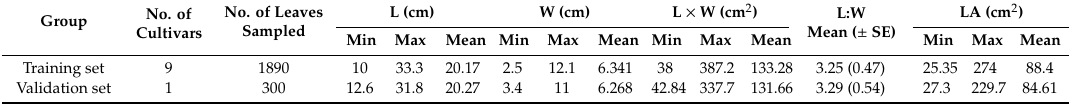
Table 1. Characteristics of predictors (L, W) and dependent variable (LA) used in this study. No. of Leaves Group No. of Cultivars